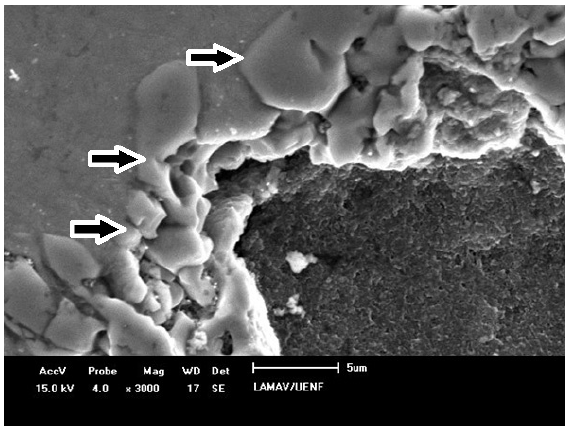
Figure 3 - Interface between Ti (light area) and Diamond (dark region) in 3000x magnification. The arrows indicate the roughness near the diamond formed by the presence of